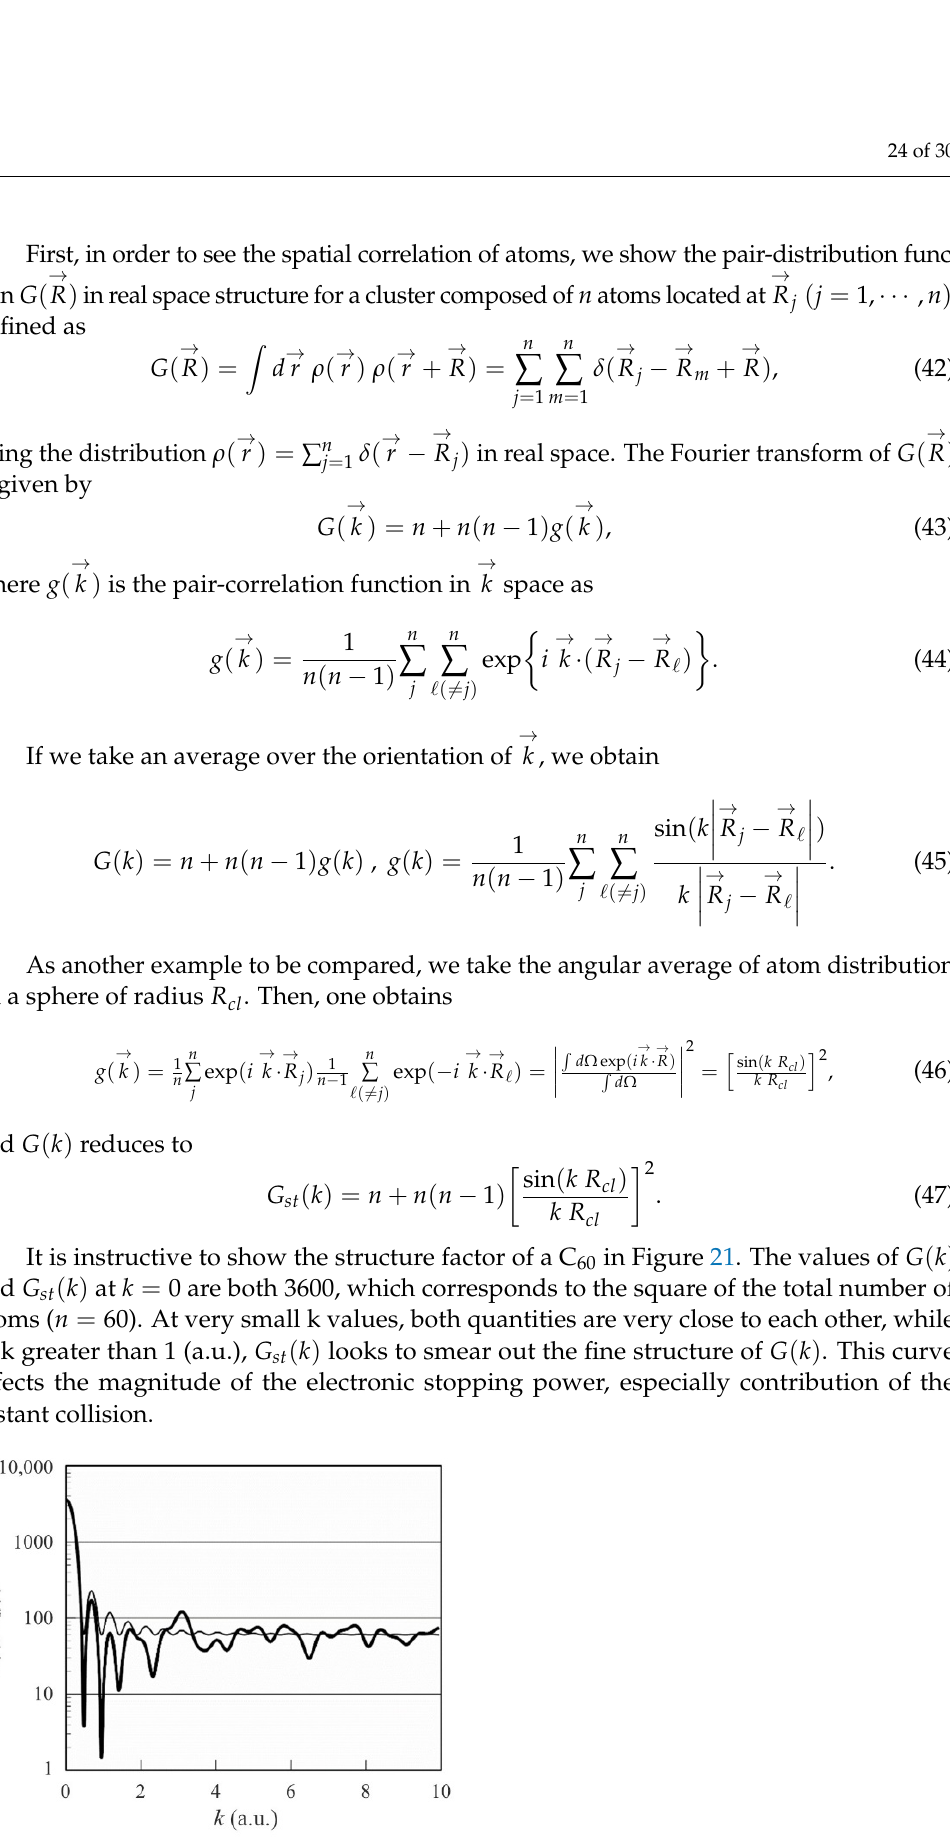
( ) st G k of a CC 60 with 0 6.6 cl R a = . The atomic unit (a.u.) of k is in units of (1/ 0 a )